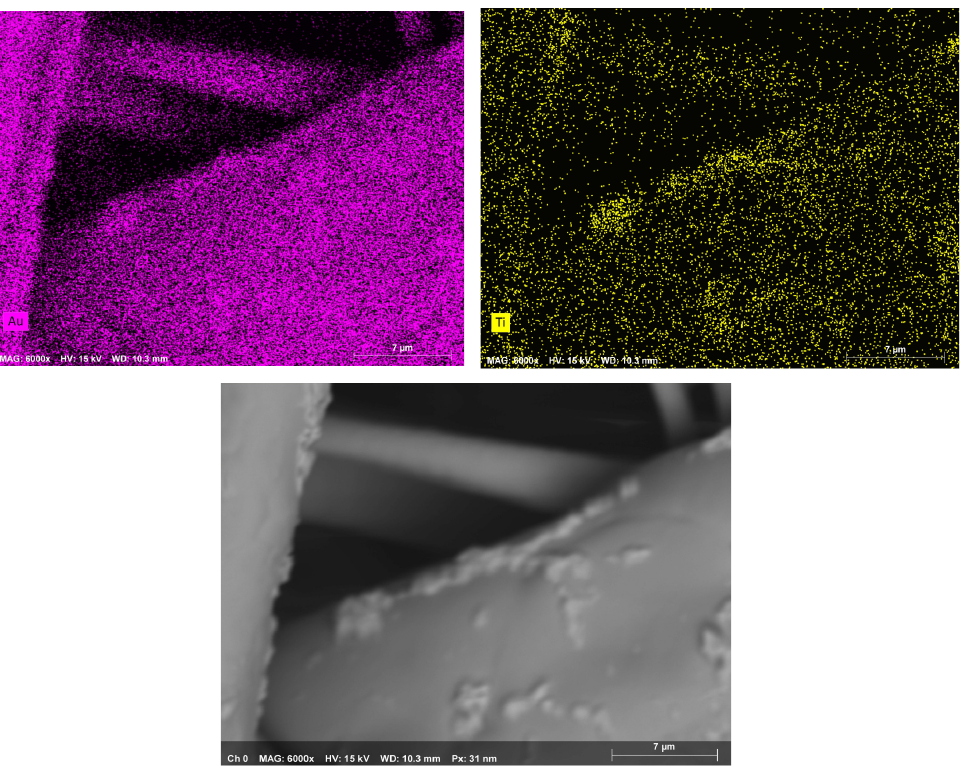
Figure 43. Presentation of a catalytic textile made from polypropylene melt blown material, equipped with a TiO 2 coating which was coated with gold by PVD. Gold mapping is shown in the top-left picture, titanium mapping on the right, and the lower image shows the corresponding SEM micrograph.